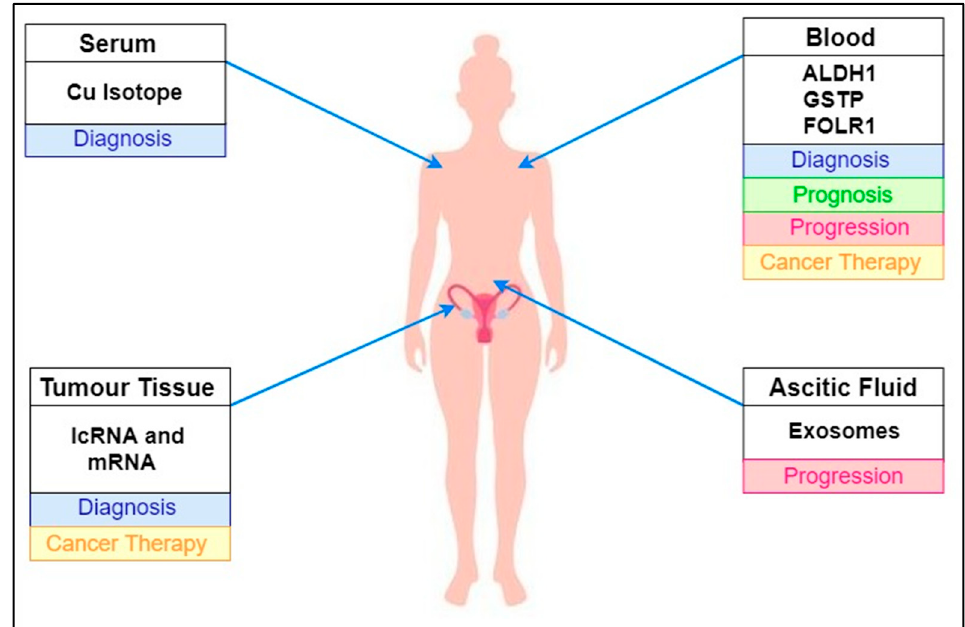
Figure 2. Summary of newly emerging ovarian cancer biomarkers highlighting their primary location in human body fluids.